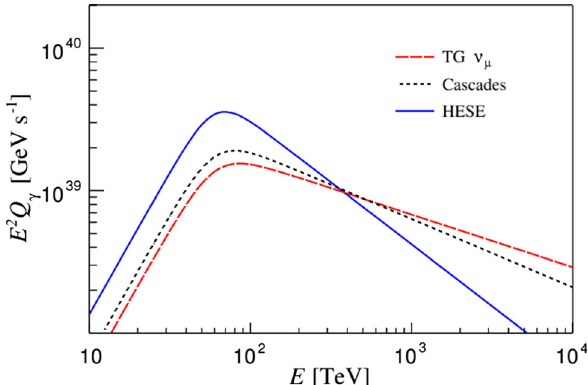
Fig. 2 Photon spectrum Q γ from a single source as a function of the energy, according to three different neutrino data-sets: TG muon neu- trinos (red dashed line), cascades (black dotted line) and HESE (blue continuous line)